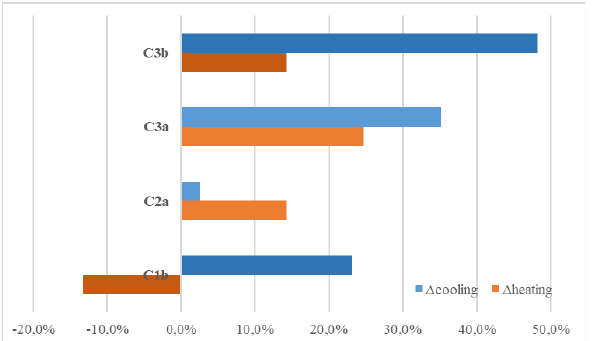
Figure 7 - Comparative assessment of energy impacts comparing building type combinations to zero one (C zero )